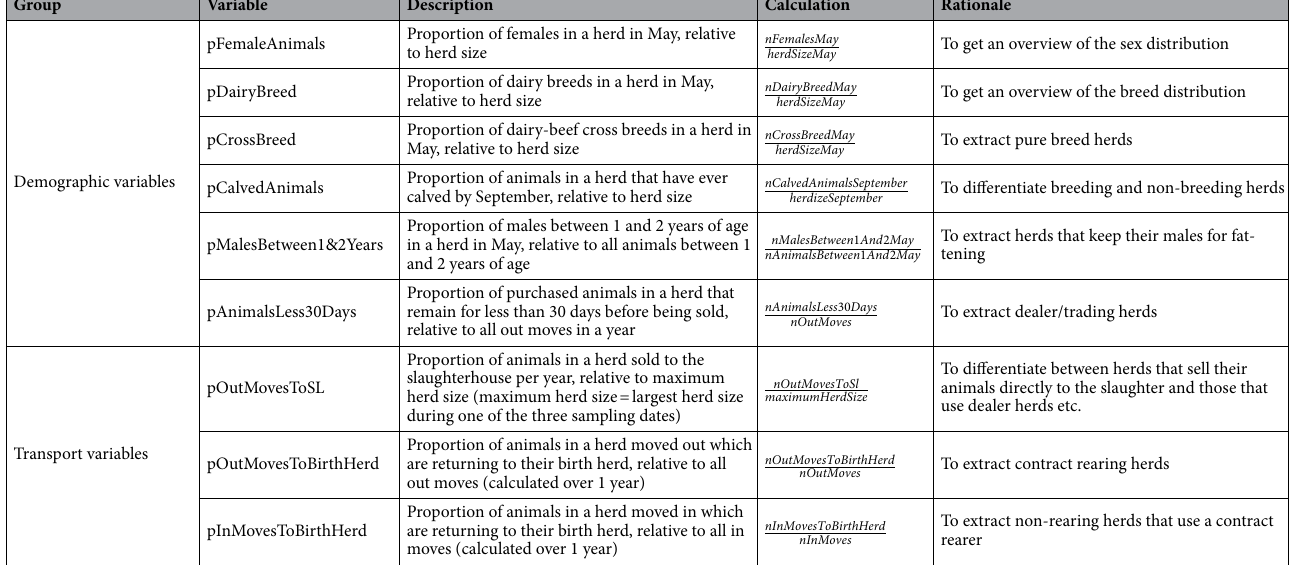
Table 1. Second order variables.